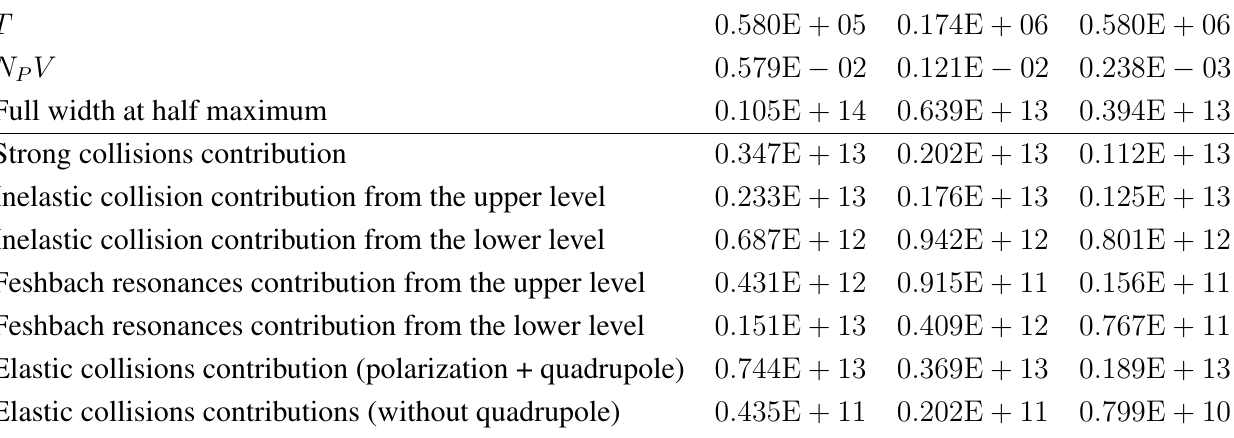
Table 3. Results of the SCP code for Ne VIII 3 s − 3 p , electron collisions. Angular frequency = 10 19 cm − 3 , temperatures T in units, density N P